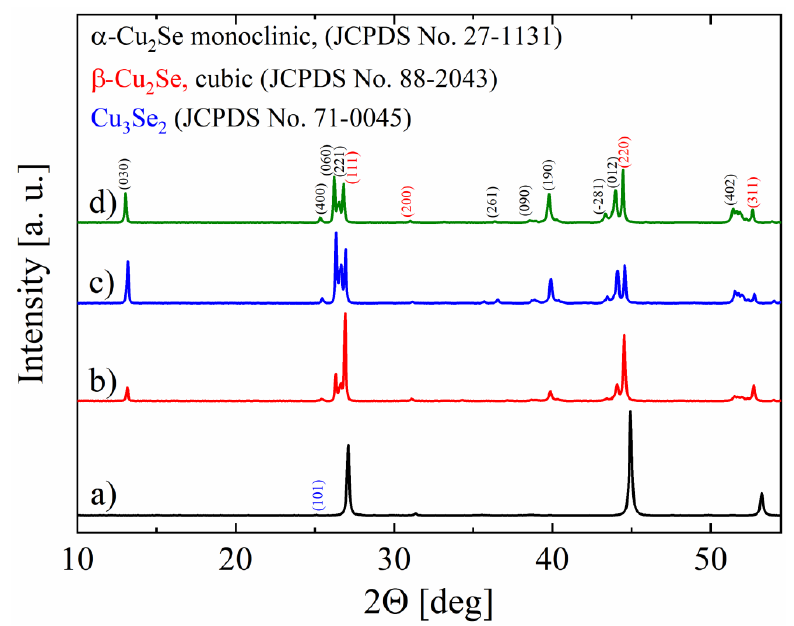
Figure 1. X-ray diffraction patterns for Cu 2 Se samples after synthesis ( a ) and after sintering by the SPS method at 550 °C ( b ), 650 °C ( c ), 720 °C ( d ).